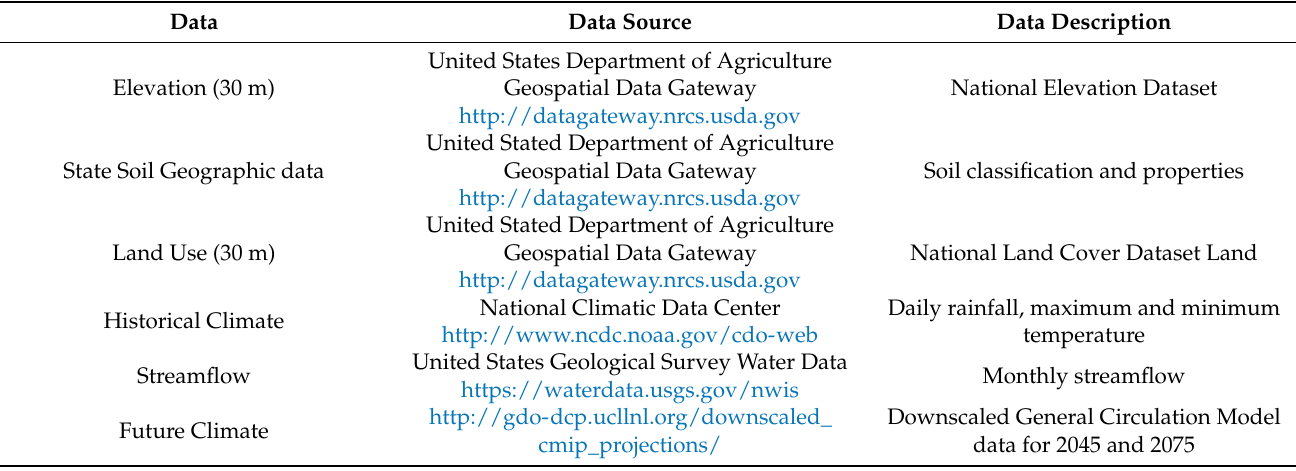
Table 1. Table showing geospatial and climate data and